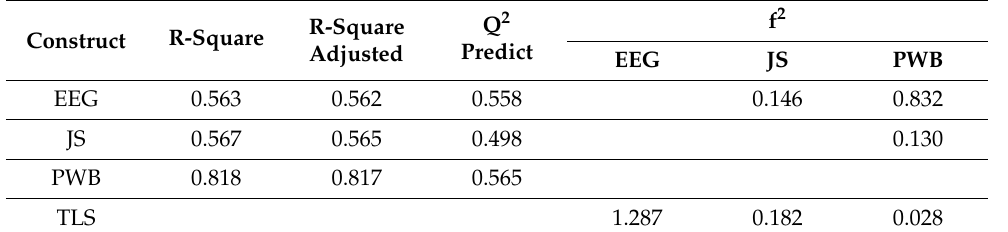
Table 5. Structural model